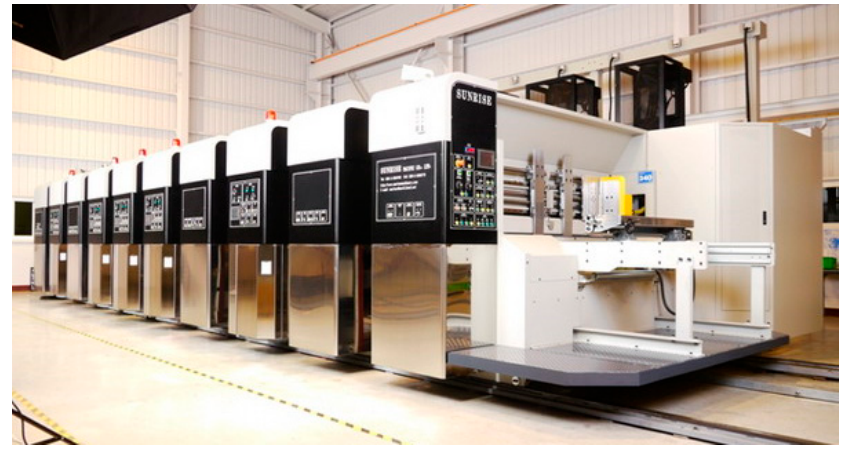
Figure 3. High-capacity fixed-type corrugated box precision printing machine (CBPPM) (http: